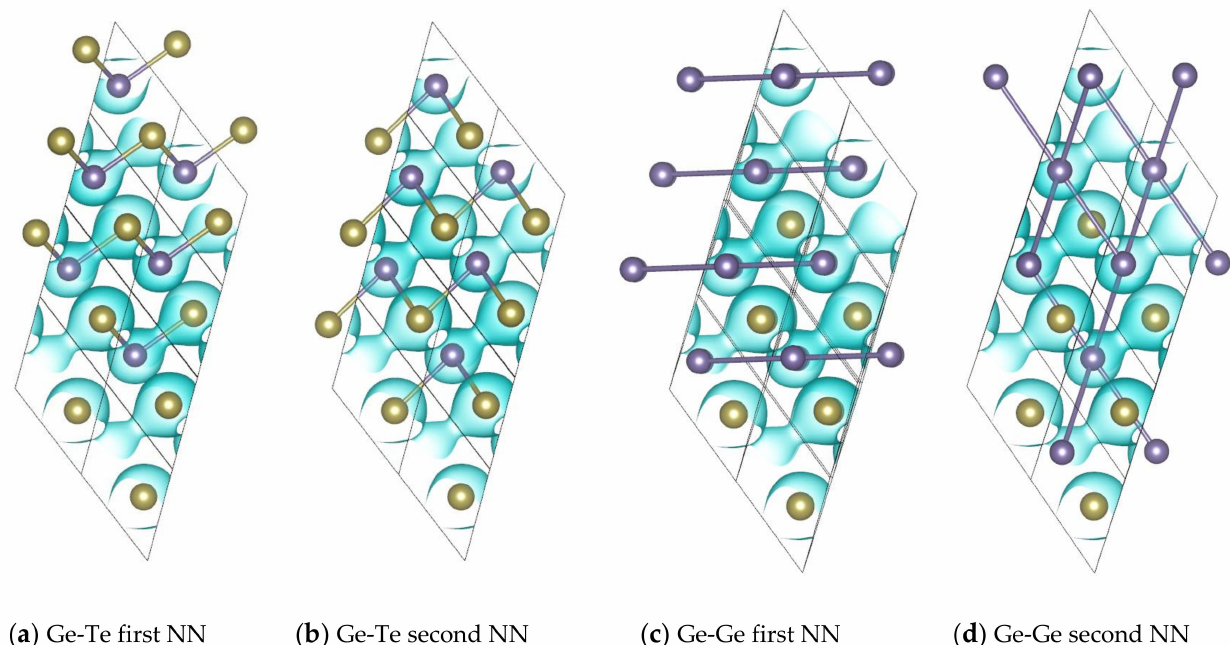
Figure 4. Crystal structures shown with the isosurface at − 0.035 electrons per bohr 3 in spatial valence charge density and the noteworthy bonds for ( a ) Ge-Te first NN, ( b ) Ge-Te second NN, ( c ) Ge-Ge first NN, and ( d ) Ge-Ge second NN. The bonds between atoms are shown with bicolor cylinder type.